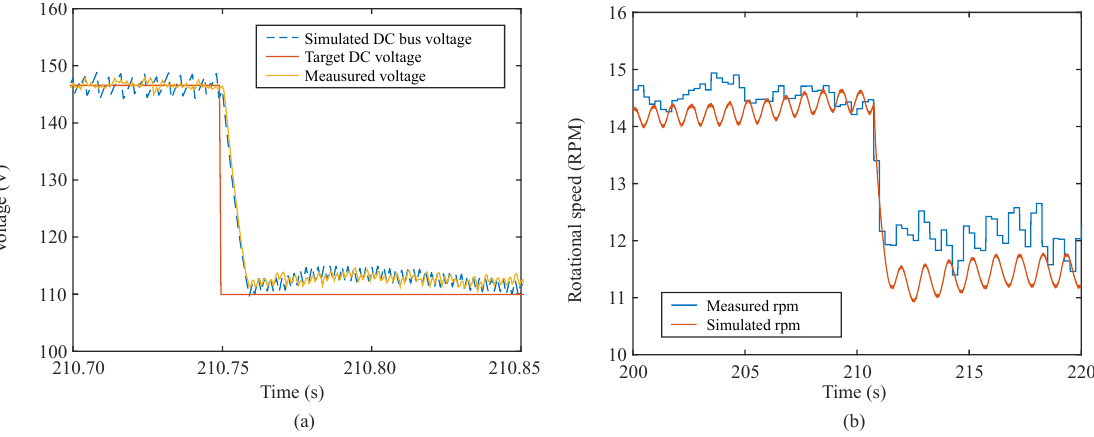
Figure 10. Simulated and experimental step response of turbine operation close to λ opt , with a step corresponding to a decrease of λ : ( a ) DC bus voltage; ( b ) Rotational speed of the